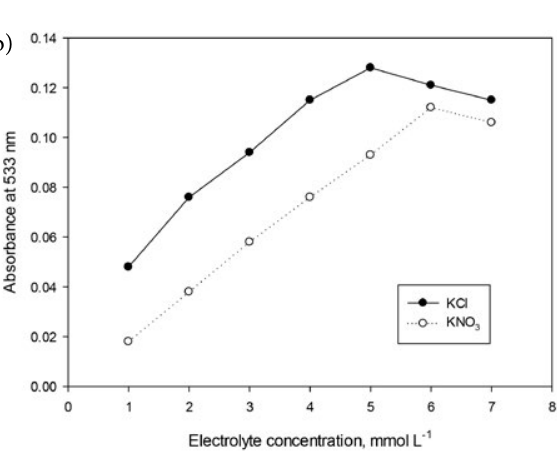
Figure 3. The influence of (a) nonionic surfactant concentration and (b) electrolyte concentration at pH 6.0 on the analytical signal. Conditions: 50 μg L –1 V(V), 0.8 mmol L –1 B-R buffer at pH 6.0, 1.6 µmol L –1 pyrogallol, 2.0 µmol L –1 safranin T at 50 °C and incubation for 3